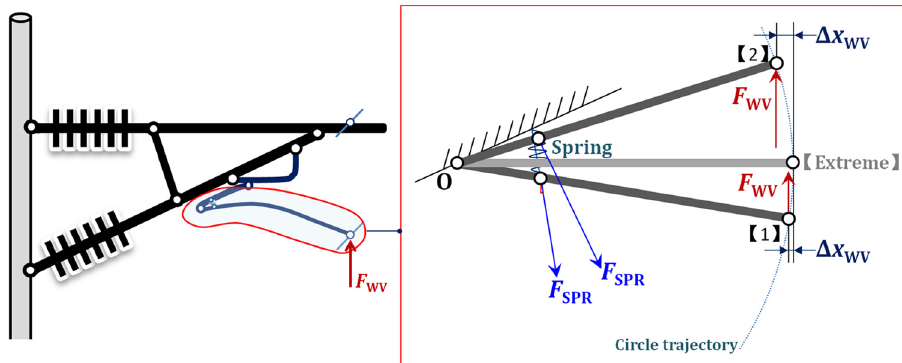
Figure 10: Mechanical diagram of the locator.